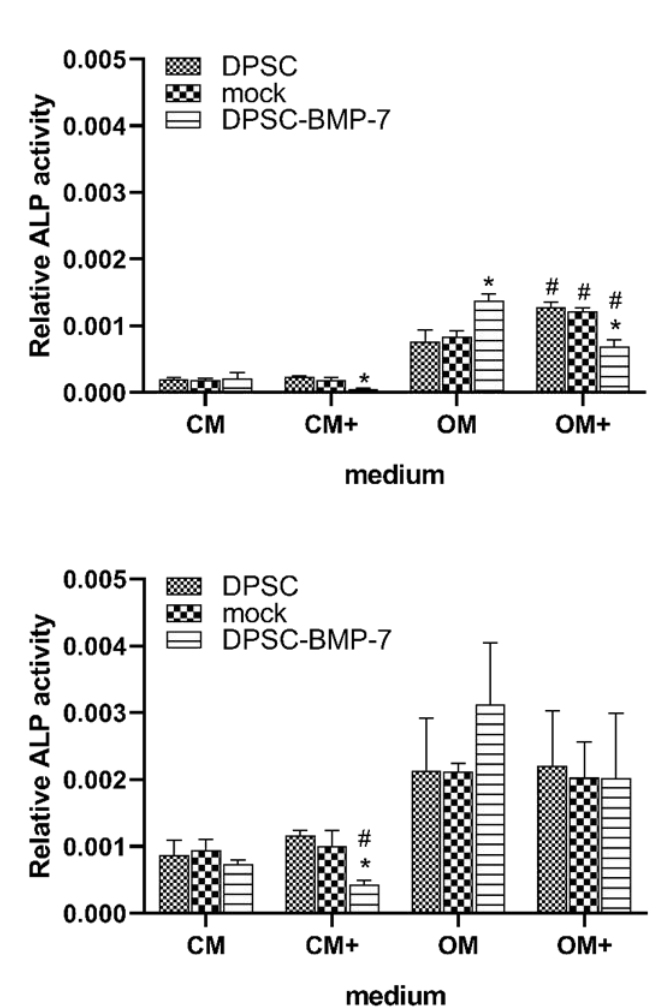
Figure 4. ALP activity of the indicated cell lines. After 1 week ( A ) and 3 weeks ( B ) of induction in different media. *, p < 0.05 vs. control (DPSC) in the same media, #, p < 0.05 vs. untreated (CM or OM respectively) group of the same cell line.